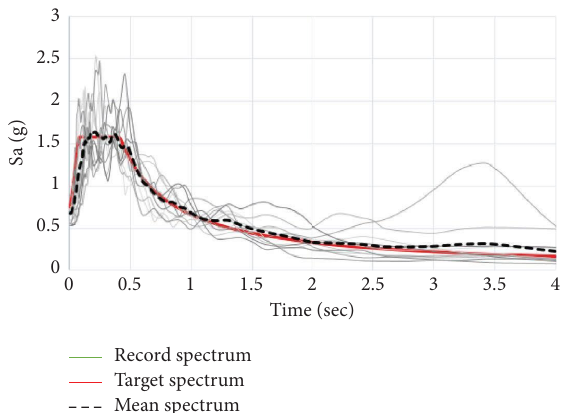
Figure 13: Target design, mean, and record spectra.